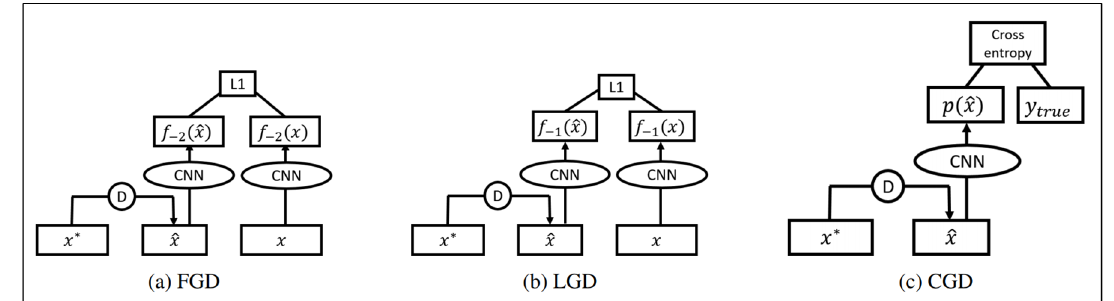
Figure 18. Three different training methods for HGD. The square boxes stand for data blobs, the circles and ovals stand for networks. D stands for denoiser. The Convolutional Neural Network (CNN) is the model to be defended. The parameters of CNN are shared and fixed (Image Credit: Liao et al.